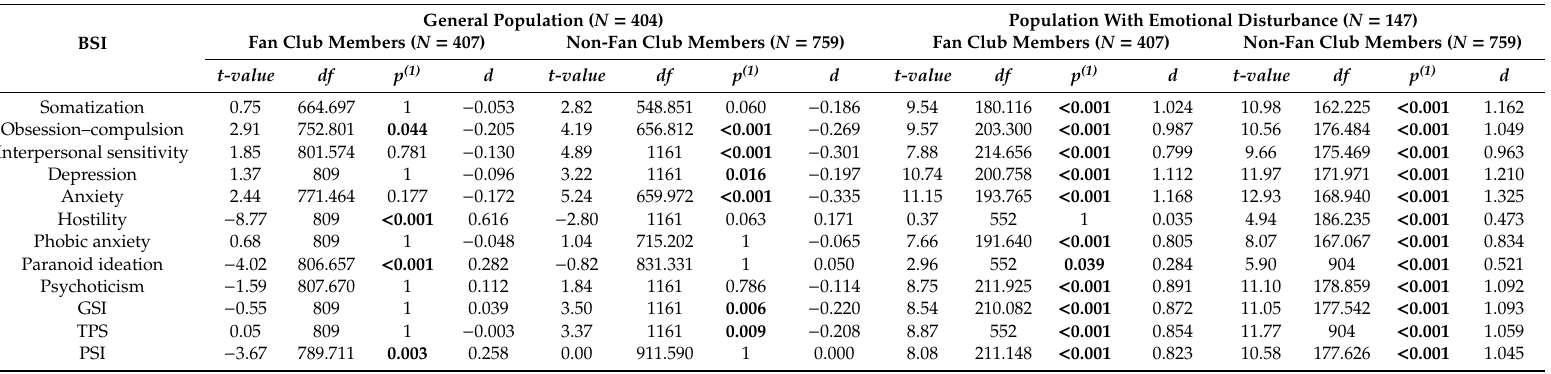
Table 4. Independent samples t -tests results with Bonferroni correction for di ff erences between: the mean values of BSI dimensions and indexes and the normative values of the BSI Portuguese version [42] in